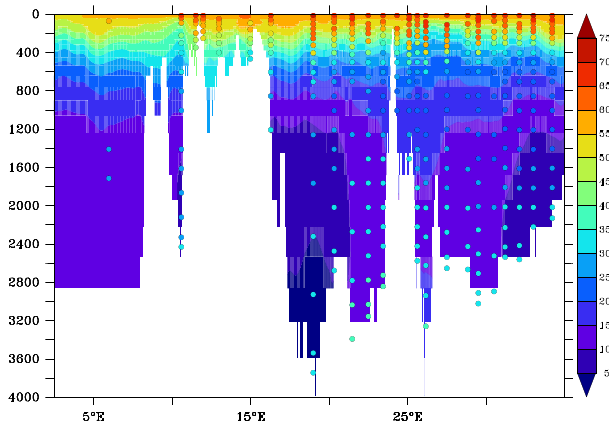
Figure 11. Comparison of δC T (µmolkg − 1 ) along the Meteor M51/2 section for the model (color-filled contours) and the TTD data-based estimates (color-filled dots) in November